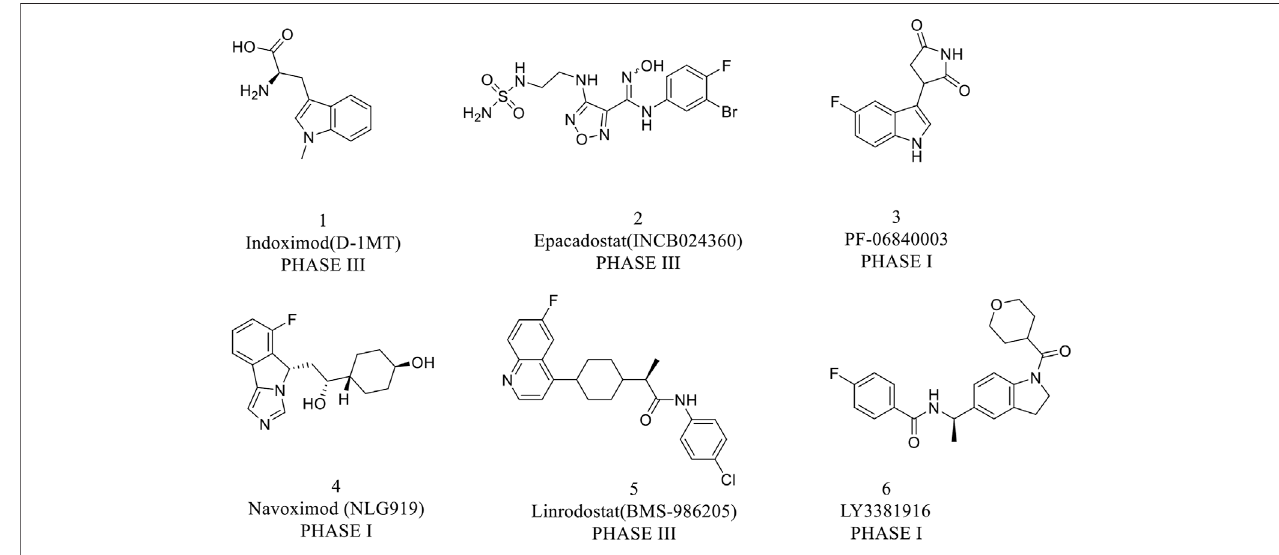
FIGURE 2 | Representative structure of IDO1 inhibitors in clinical